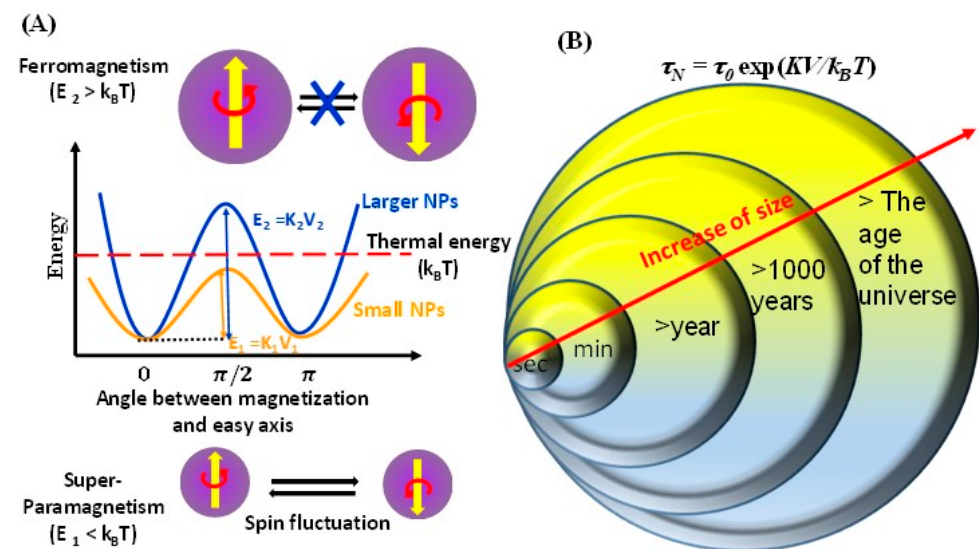
Figure 3. ( A ) The top of (A) depicts the reversal of magnetization in ferromagnetic particles. The energy diagram below illustrates the di ff erence in energy barrier for a large particle behaving as ferromagnet and a small particle behaving as superparamagnet. The bottom of (A) depicts the relaxation process in superparamagnetic particles. ( B ) A typical correlation between the N é el relaxation time and the MNPs diameters. MNPs with extremely high τ N are promising for recording media applications.